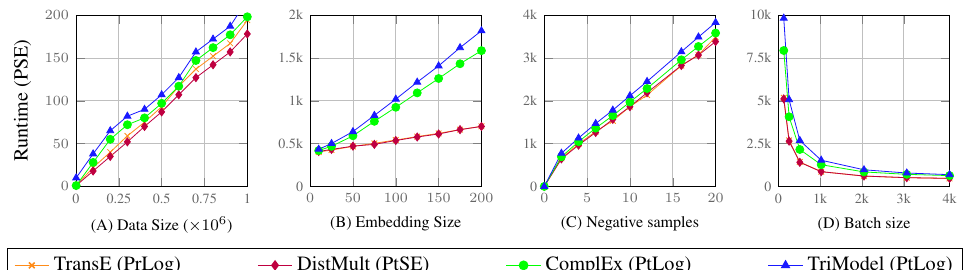
Figure 5. A set of line plots which describe the changes of training data sizes and training hyperparameters and their e ff ects on the training runtime of the TransE, DistMult, TriModel and ComplEx models on the PSE dataset. The runtime is reported in second for all the